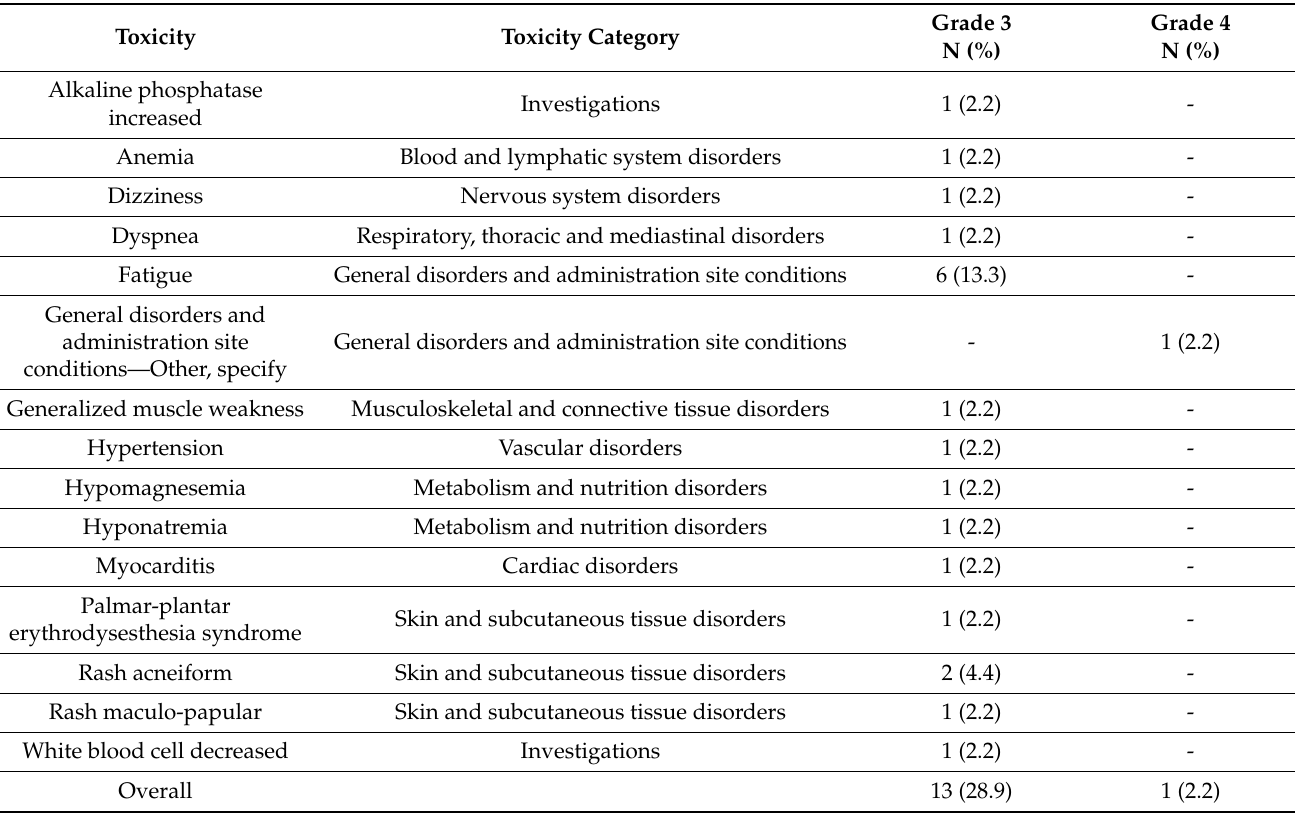
Table 2. Treatment-Related Adverse Events.